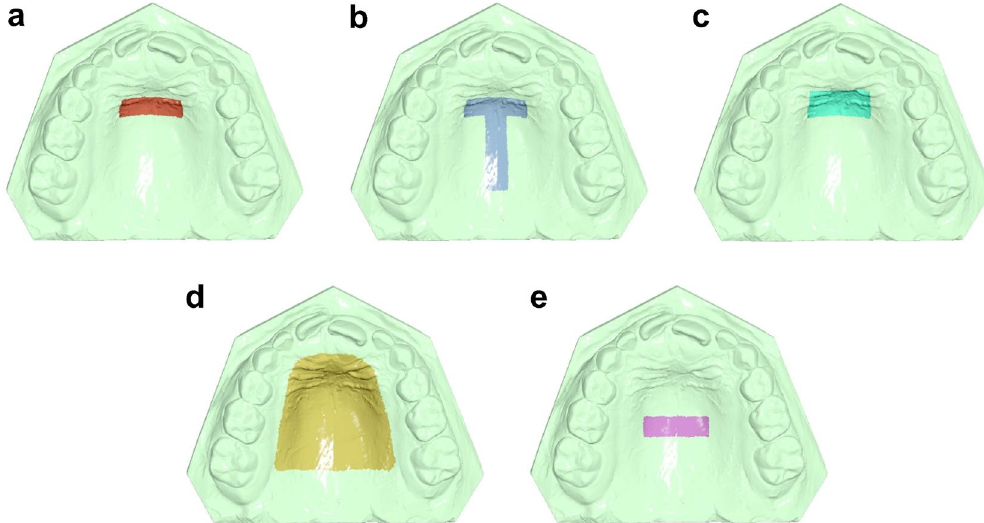
Figure 1. Superimposition reference areas used in the study. ( a ) The area of the palate limited anteriorly by the medial 2/3 of the third rugae and laterally by two lines parallel to the midpalatal suture and extending posteriorly 5 mm from the third rugae. ( b ) Area A, plus a 6 mm wide stripe on the midpalatal suture extending posteriorly to the level of a line connecting the lingual grooves of the 1 st permanent molars at the gingival level. ( c ) An area similar to A, but starting anteriorly from the medial 2/3 of the second rugae. ( d ) Almost the whole palate delimited by a line 5 mm distant from all gingival margins and extending posteriorly until a line connecting the lingual grooves of the 1 st permanent molars at the gingival level. ( e ) An area of similar extent and transversal position to area A, but starting anteriorly at a line that connects the interproximal areas of the primary molars.